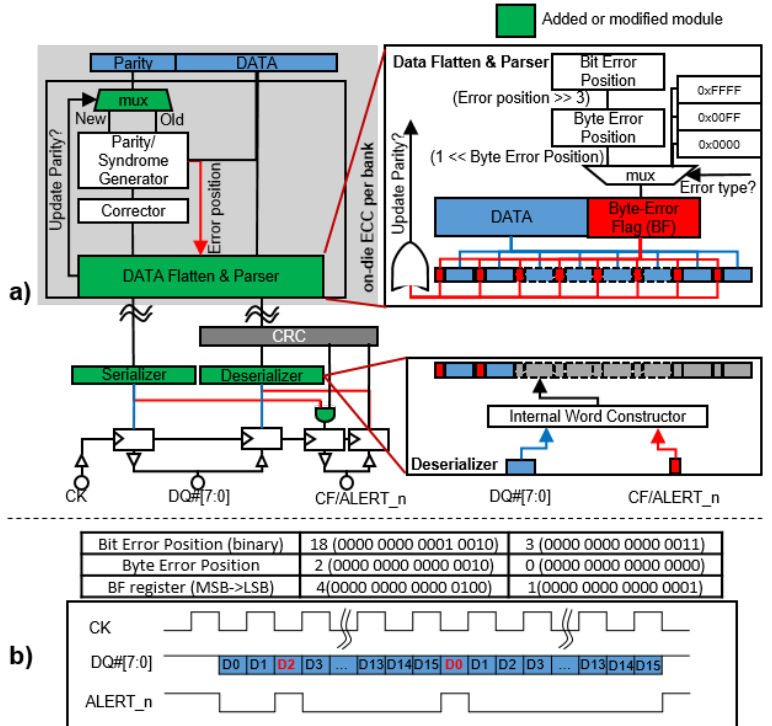
Figure 3. A description of the byte-error tracking module in the DRAM architecture: ( a ) the byte-error flag DRAM architecture and ( b ) an example of byte-error flag timing, replying on the 18th bit and 3rd bit of the first and second DRAM words (note: the green modules are our modifications in